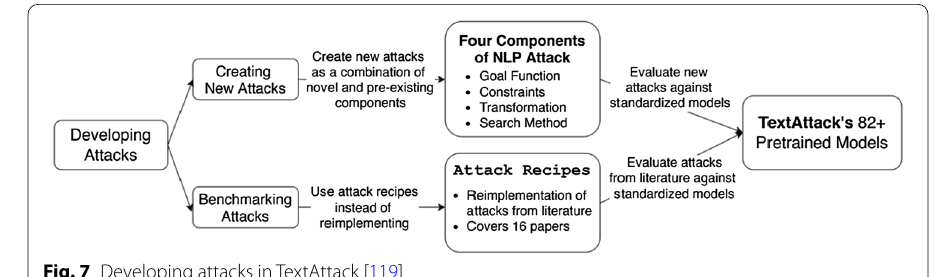
Fig. 7 Developing attacks in TextAttack